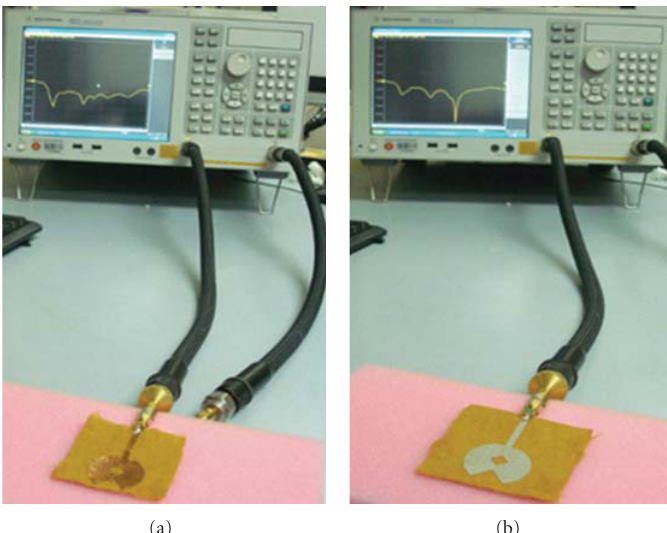
Figure 3: Snapshot of ( | S 11 | ) measurement environment of both antenna prototypes using (a) copper conducting tape and (b) Shieldit conducting fabric.